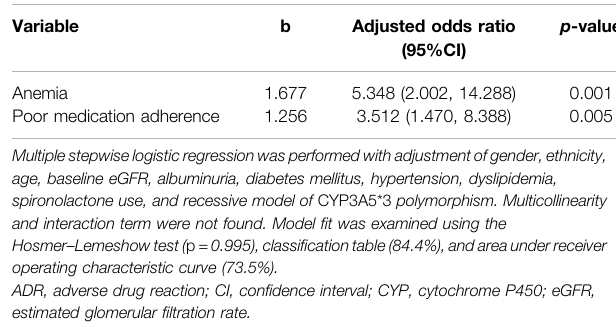
TABLE 3 | Factors associated with antihypertensive-related ADR (multiple logistic regression).